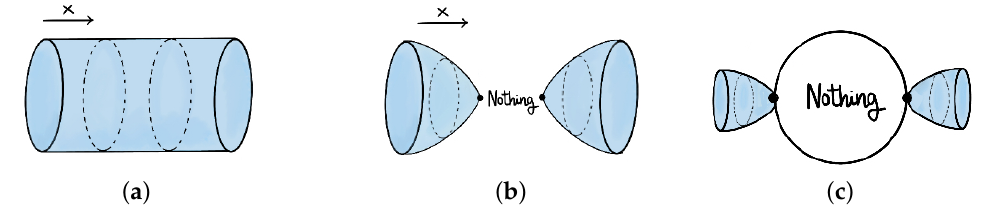
Figure 3. ( a ) Illustration of an extra circular dimension, the x -direction represents the non-compact space. ( b ) If the size of the extra dimension (i.e., the circle) is reduced along the non-compact direction until it eventually reaches zero size, a region of space is removed (the one that corresponds to the values of x that are between the two black dots). ( c ) A bubble of nothing in more dimensions is obtained when the size of the extra dimension becomes zero at the boundary of such a region. Here we have represented this schematically only at two points in the boundary of the bubble, but in reality there would be one cigar-like blue figure attached to each point on the boundary of the